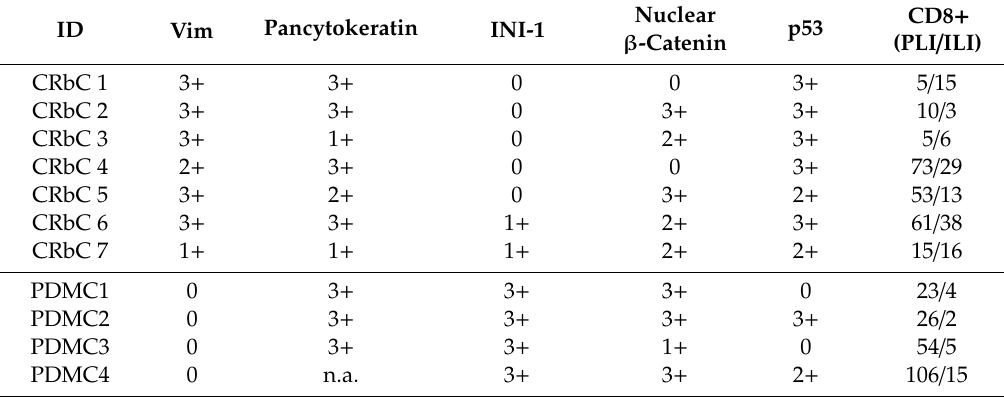
Table 3. Main immunohistochemical results in CRbCs and PDMCs included in this